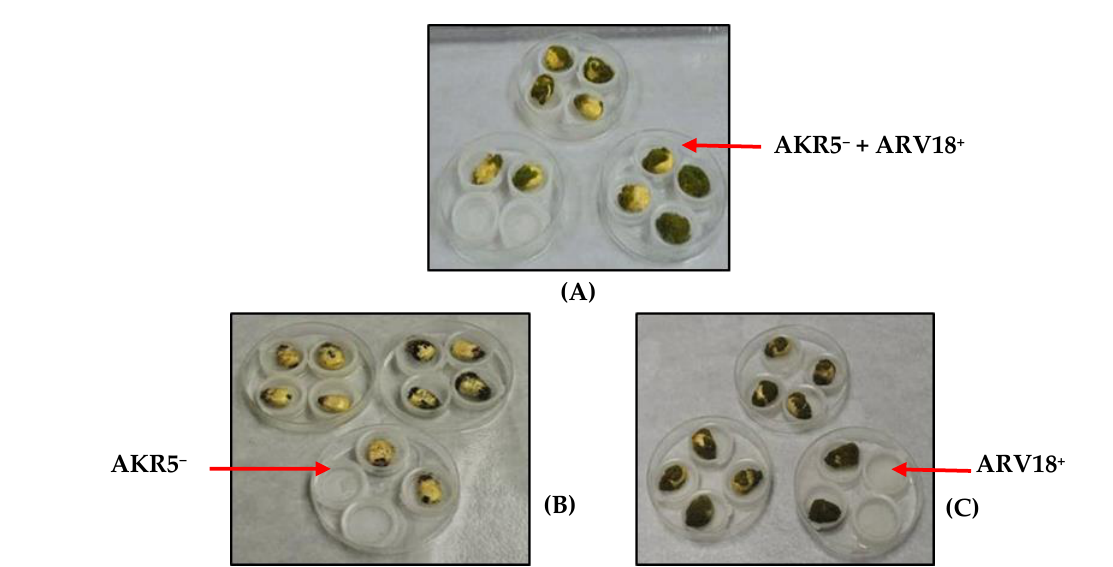
Figure 3. Images of the AKR5 − and ARV 18 + strains; ( A ) AKR5 − and ARV 18 + strains were grown on corn kernels in mixtures; ( B , C ) AKR5 − and ARV 18 + strains were grown on corn kernels separately following on 7 d of incubation.